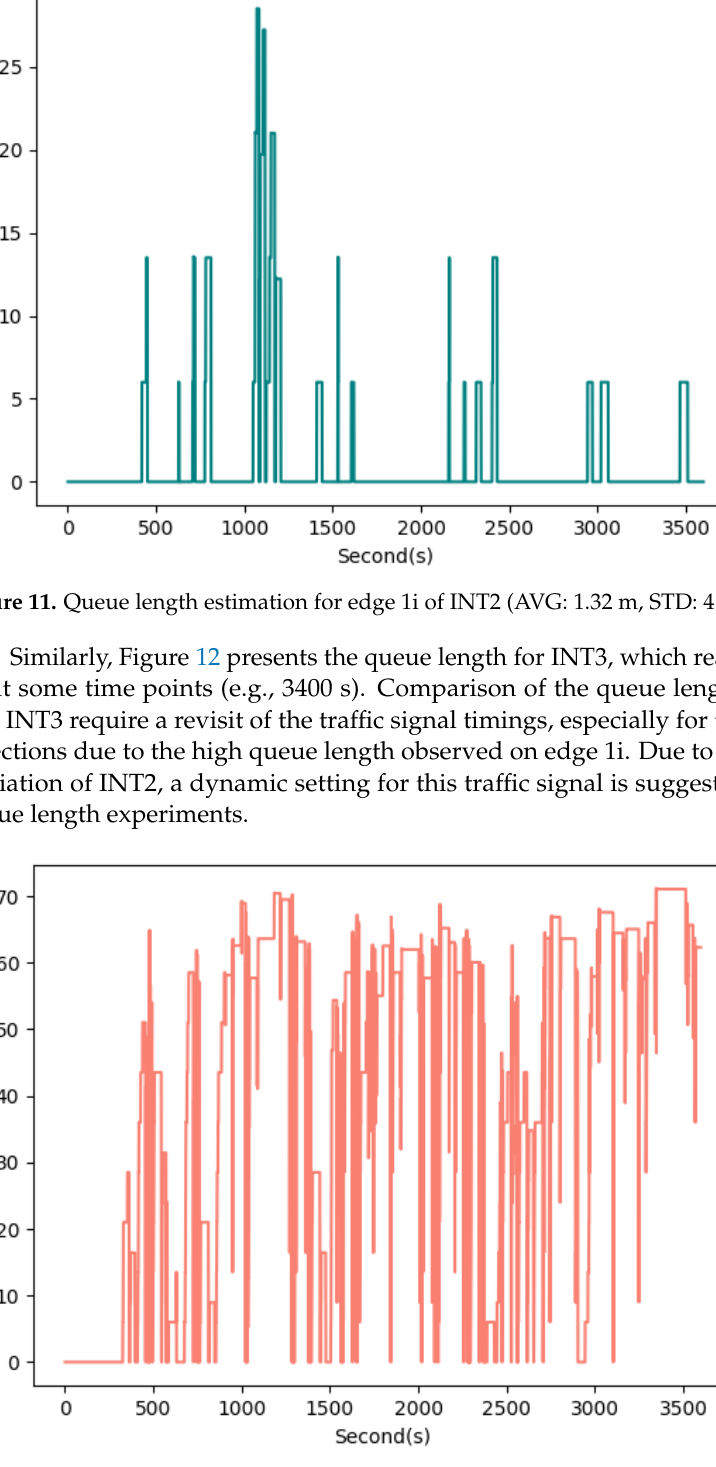
Figure 12. Queue length estimation for edge 1i of INT3 (AVG: 42.15 m, STD: 25.74